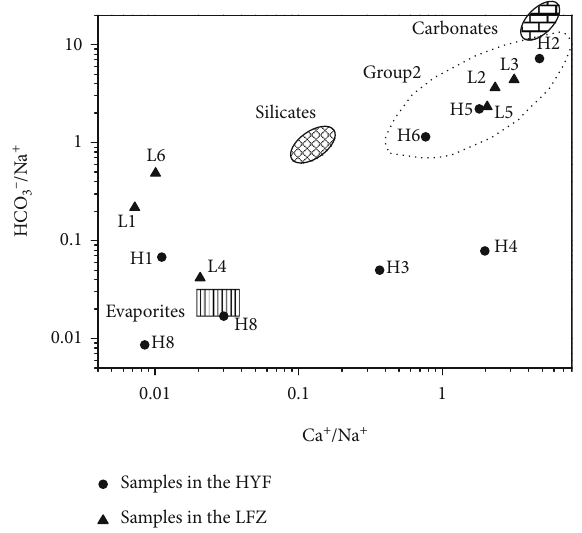
Figure 4: Molar ratio bivariate plots of Na + -normalized Ca 2+ vs. Na + -normalized HCO 3- for the water samples were collected from HFZ and